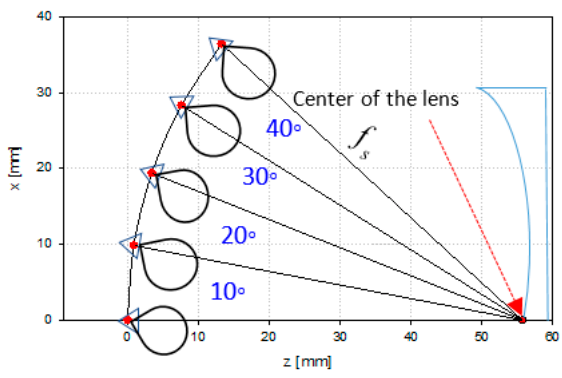
Figure 19. Feed position arrangement.